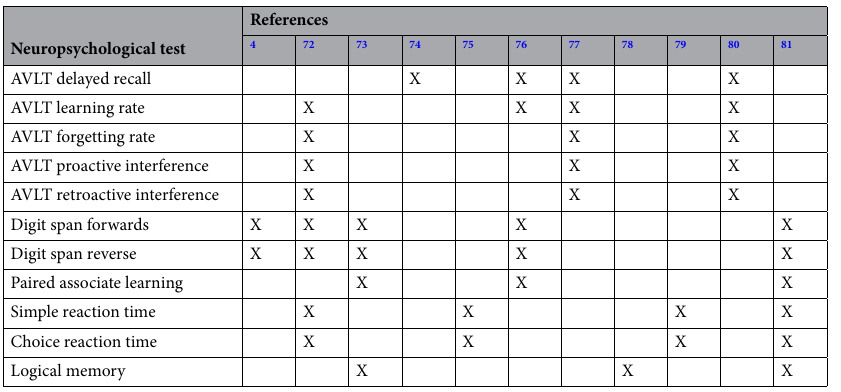
Table 1. Neuropsychological tests that were found to have a statistically significant improvement in the B . monnieri treated patients compared to the placebo.